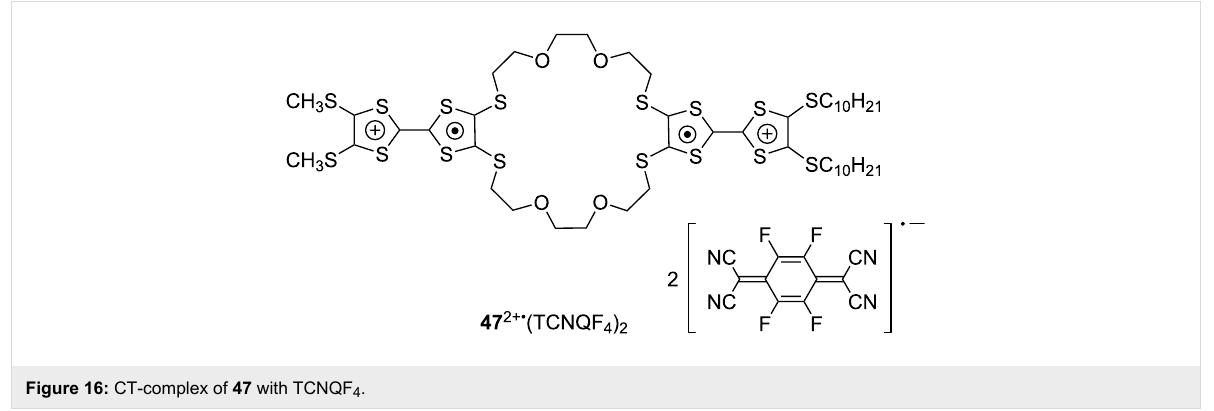
Figure 16: CT-complex of 47 with TCNQF 4 .